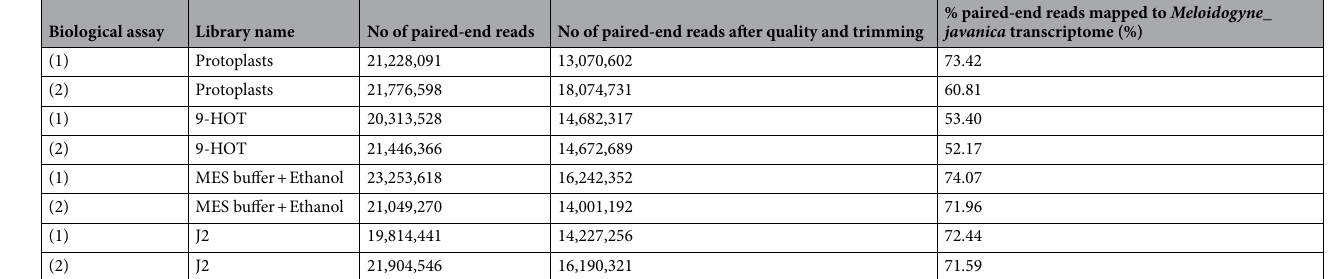
Table 2. Summary of statistics for individual RNA-Seq paired-end reads and